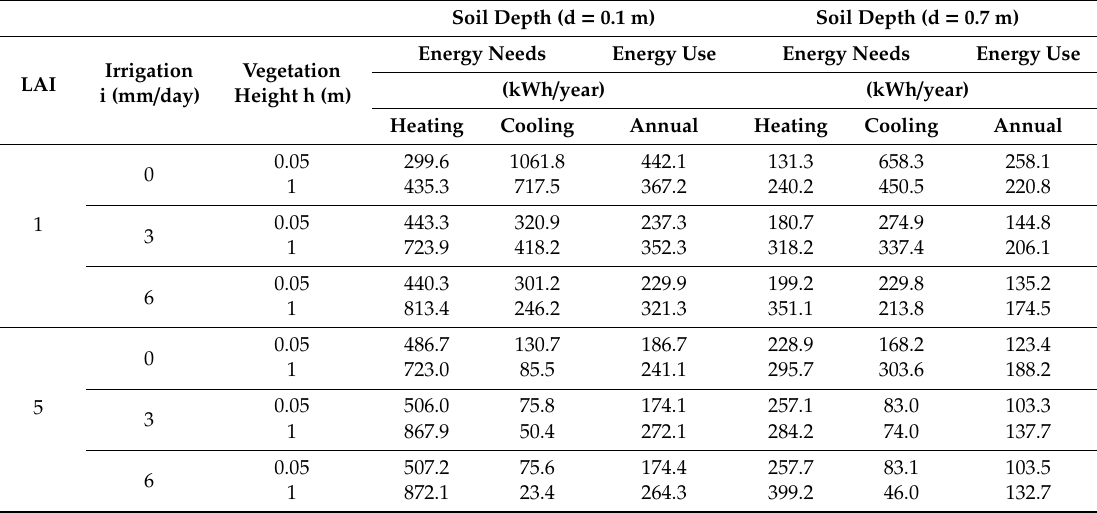
Table 2. Heating and cooling energy needs and the annual energy needs for all tests of the parametric analyses.